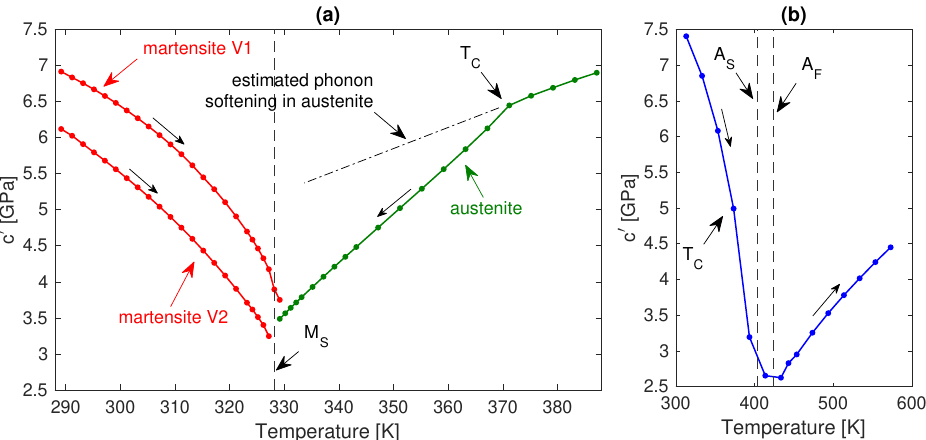
Figure 3. Evolution of the elastic constant c (cid:48) for the Ni-Mn-Ga samples: ( a ) sample No.2 with the transition temperature below the Curie point T C ; ( b ) sample No.3 with the transition temperature above the curie point. In ( a ), the constants c (cid:48) for two tetragonal variants of martensite V1 and V2 are effective elastic constants only, obtained under the assumption that the material has a cubic symmetry (see the text for more details); the dash-dot line is the extrapolation of the behavior of austenite above the Curie point. In ( b ), the c (cid:48) below A S is again an effective parameter, representing the initial mixture of variants. Note the different temperature scales between ( a , b